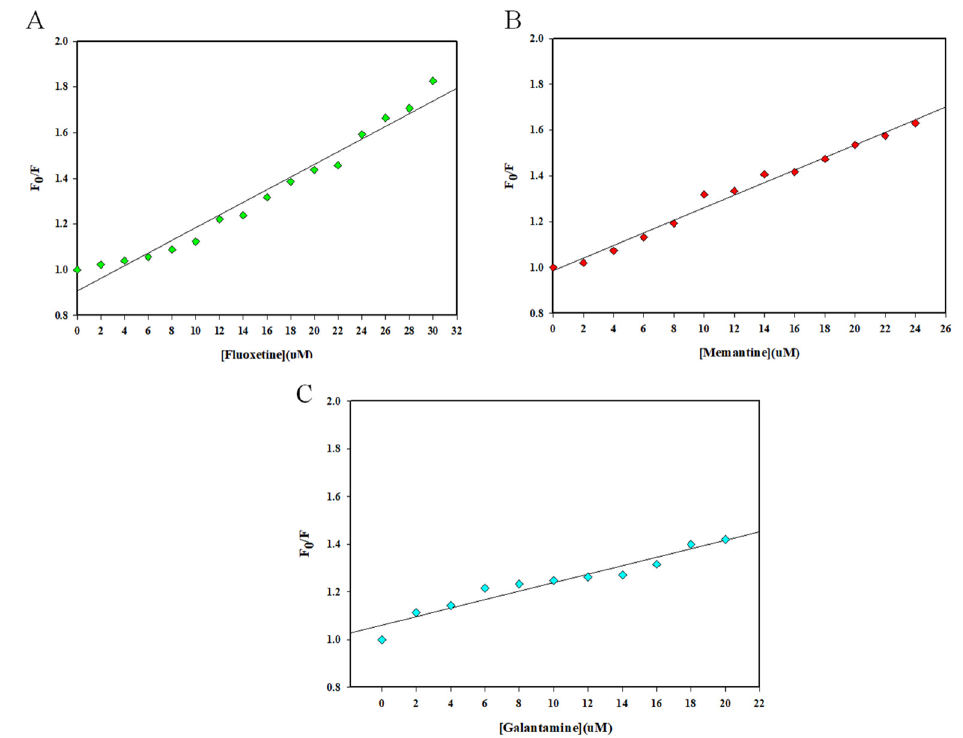
Figure 3. Stern–Volmer plot for the quenching of irisin fluorescence by ( A ) Fluoxetine, ( B ) Memantine, and ( C ) Galantamine. Table 1. Values of Stern–Volmer quenching constants obtained from Stern–Volmer